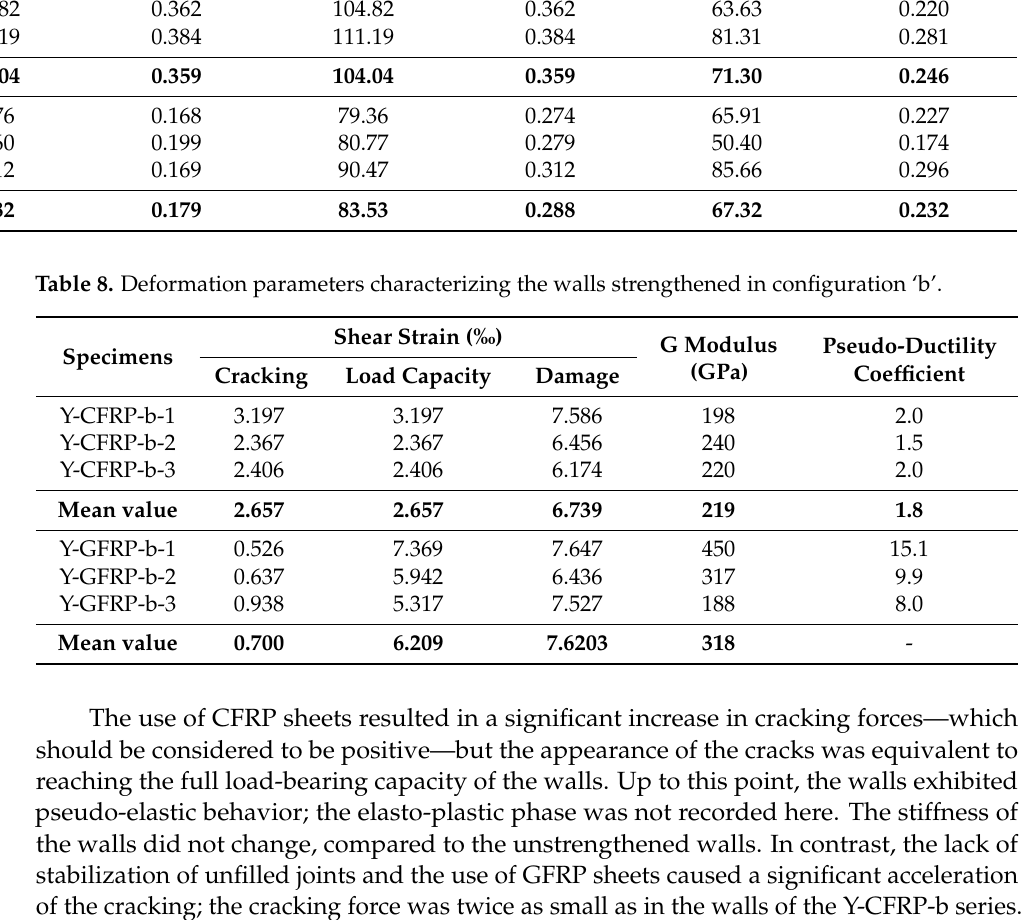
strengthened walls: ( a ) the elements with carbon strips; ( b ) the elements with glass strips.